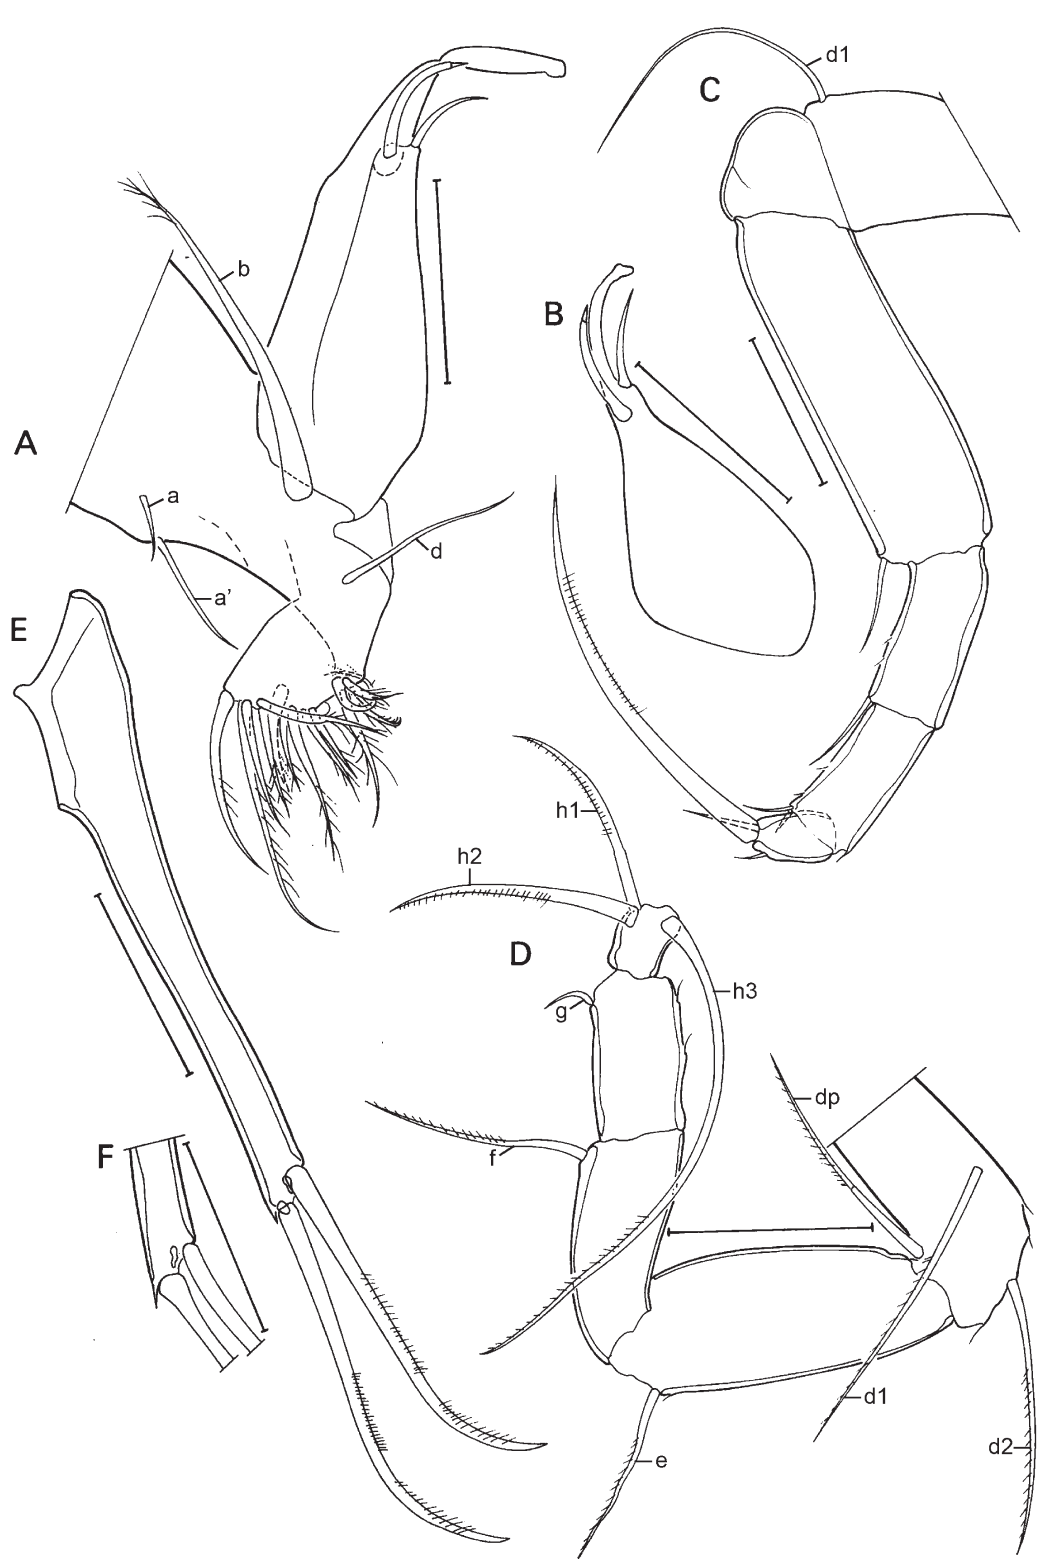
Fig. 4. Candobrasilopsis rochai gen. nov. sp. nov., limbs (♂). A . T1, left clasping organ (MZUSP.28114). B . Right clasping organ (MZUSP.28114). C . T2 (MZUSP.28114). D . T3 (MZUSP.28104). E . Caudal ramus (MZUSP.28104). F . Detail of caudal ramus (MZUSP.28115). Scale bars: A-F = 50